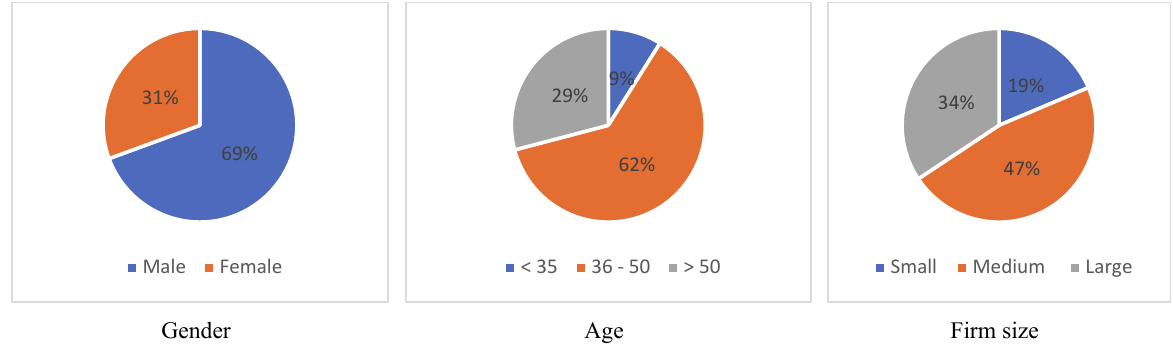
Fig. 2. Demographics of the participants